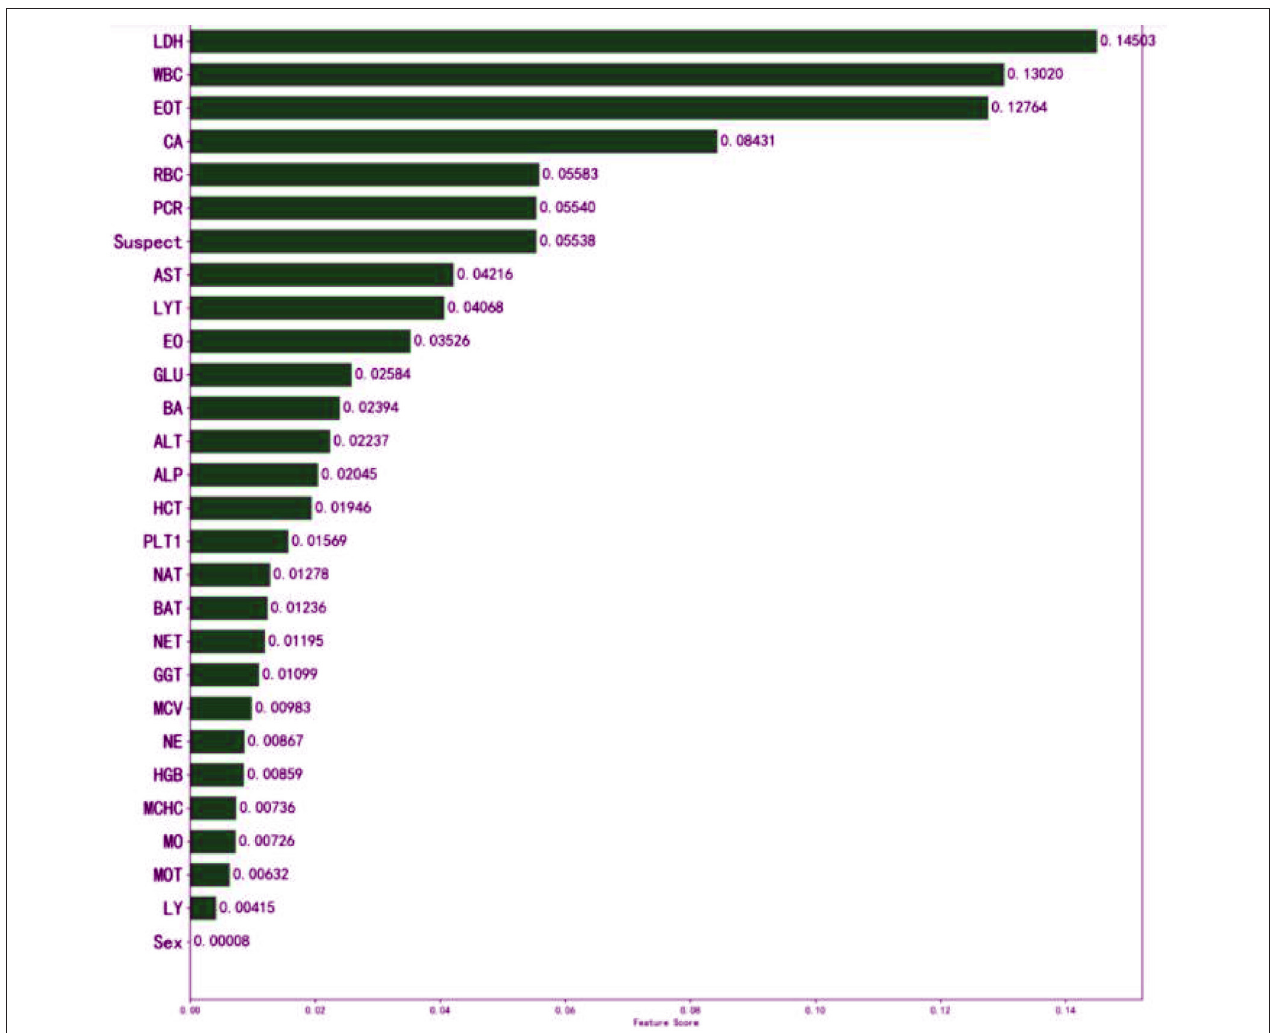
FIGURE 4 | Influence of input features on the outcome of the XGBoost model. The top three features are LDH, WBC, and EOT. It indicates that they have important auxiliary diagnostic significance for COVID-19. The model found that patients with higher WBC count, higher LDH level, or higher EOT count, were more likely to have COVID-19. It might assist physicians to make their